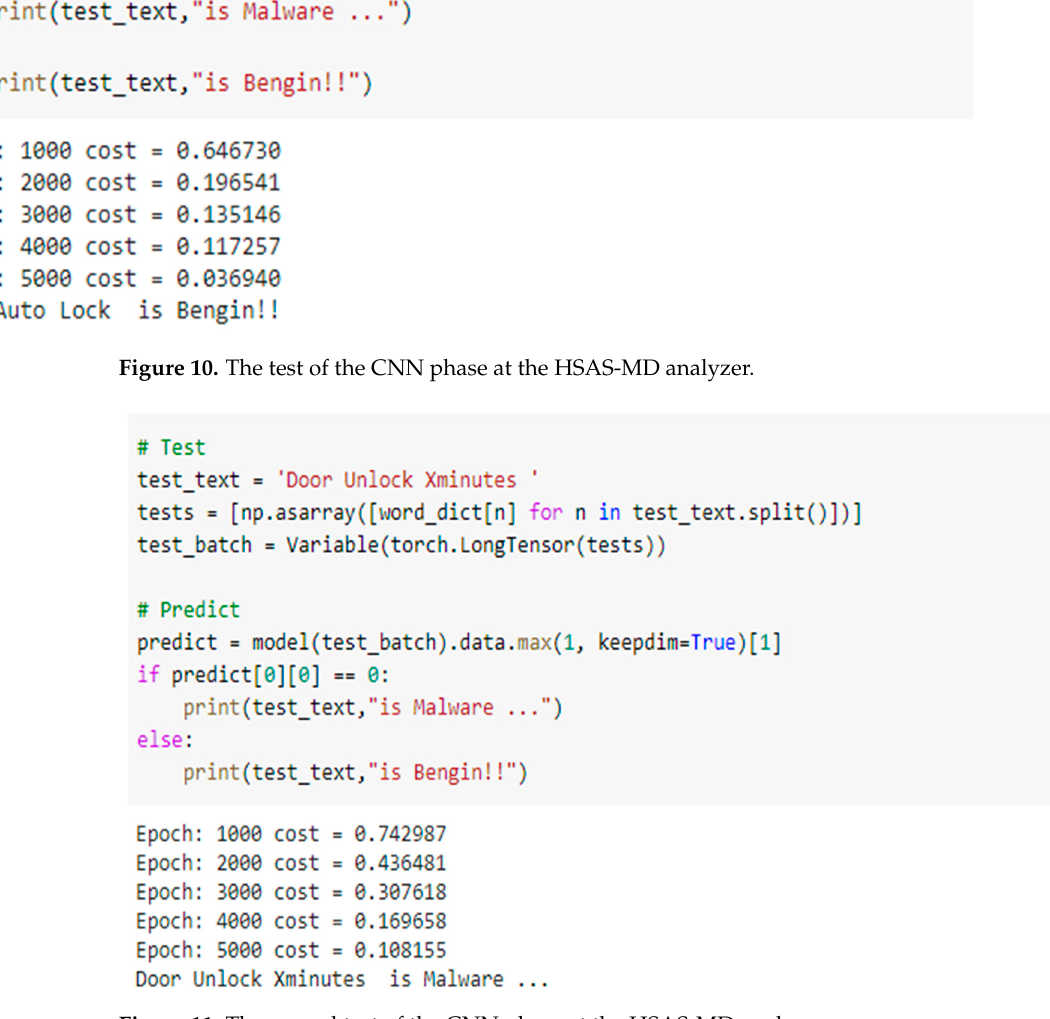
Figure 11. The second test of the CNN phase at the HSAS-MD analyzer.